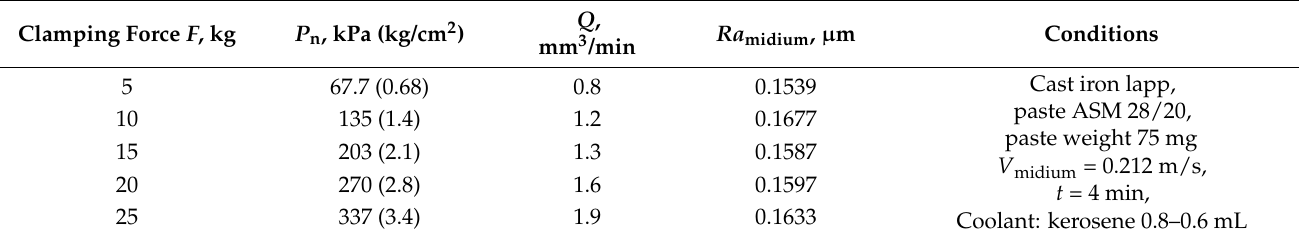
Table 7. Influence of pressure on the productivity and roughness of the lapped surface.